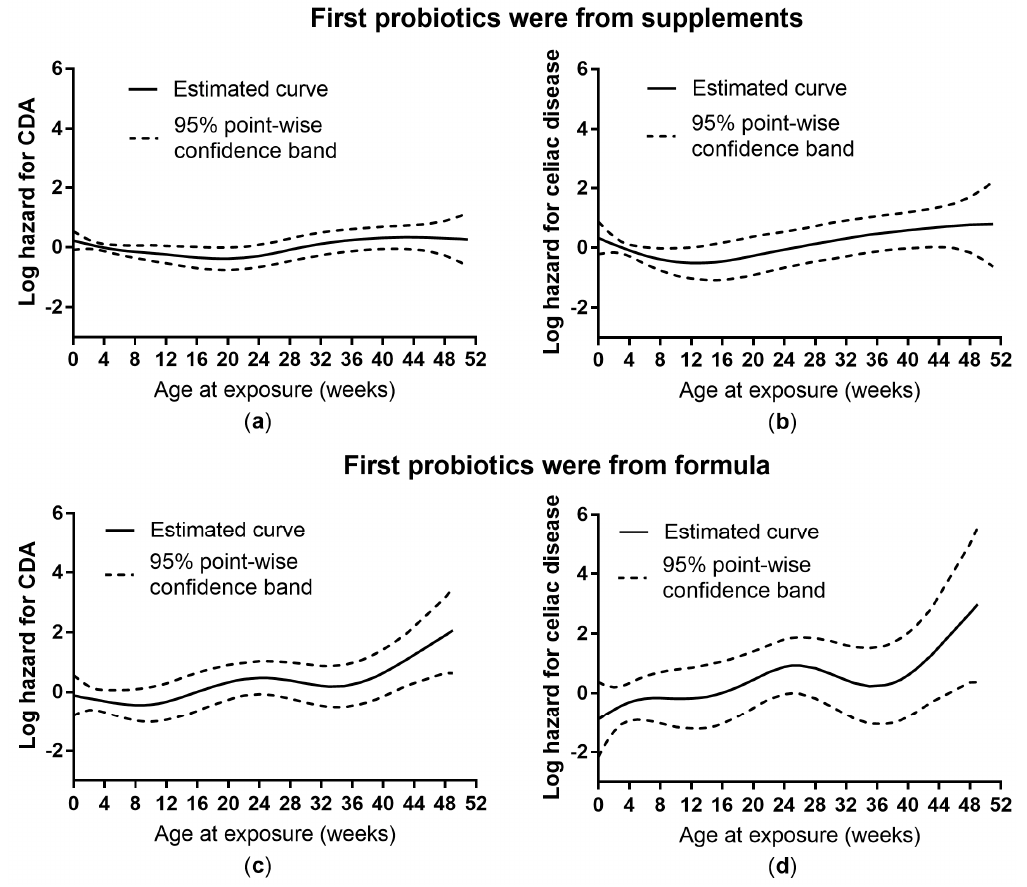
Figure 1. The estimated effects of age at probiotic exposure (by source of probiotics) on the log hazards of celiac disease autoimmunity (CDA, n = 281) ( a , c ; nonlinearity: p = 0.054 and p = 0.16, respectively) and celiac disease ( n = 99) ( b , d ; nonlinearity: p = 0.16 and p = 0.20, respectively) from time-to-event analysis with smoothing splines on 1460 subjects who were exposed to probiotics during the first year of life.